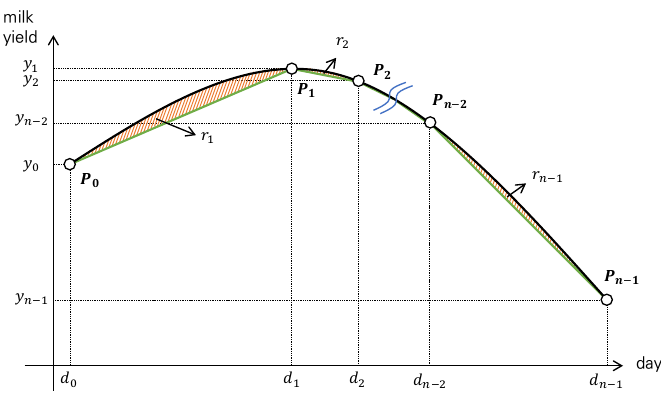
Figure 2. PWLR presentation of an LC.